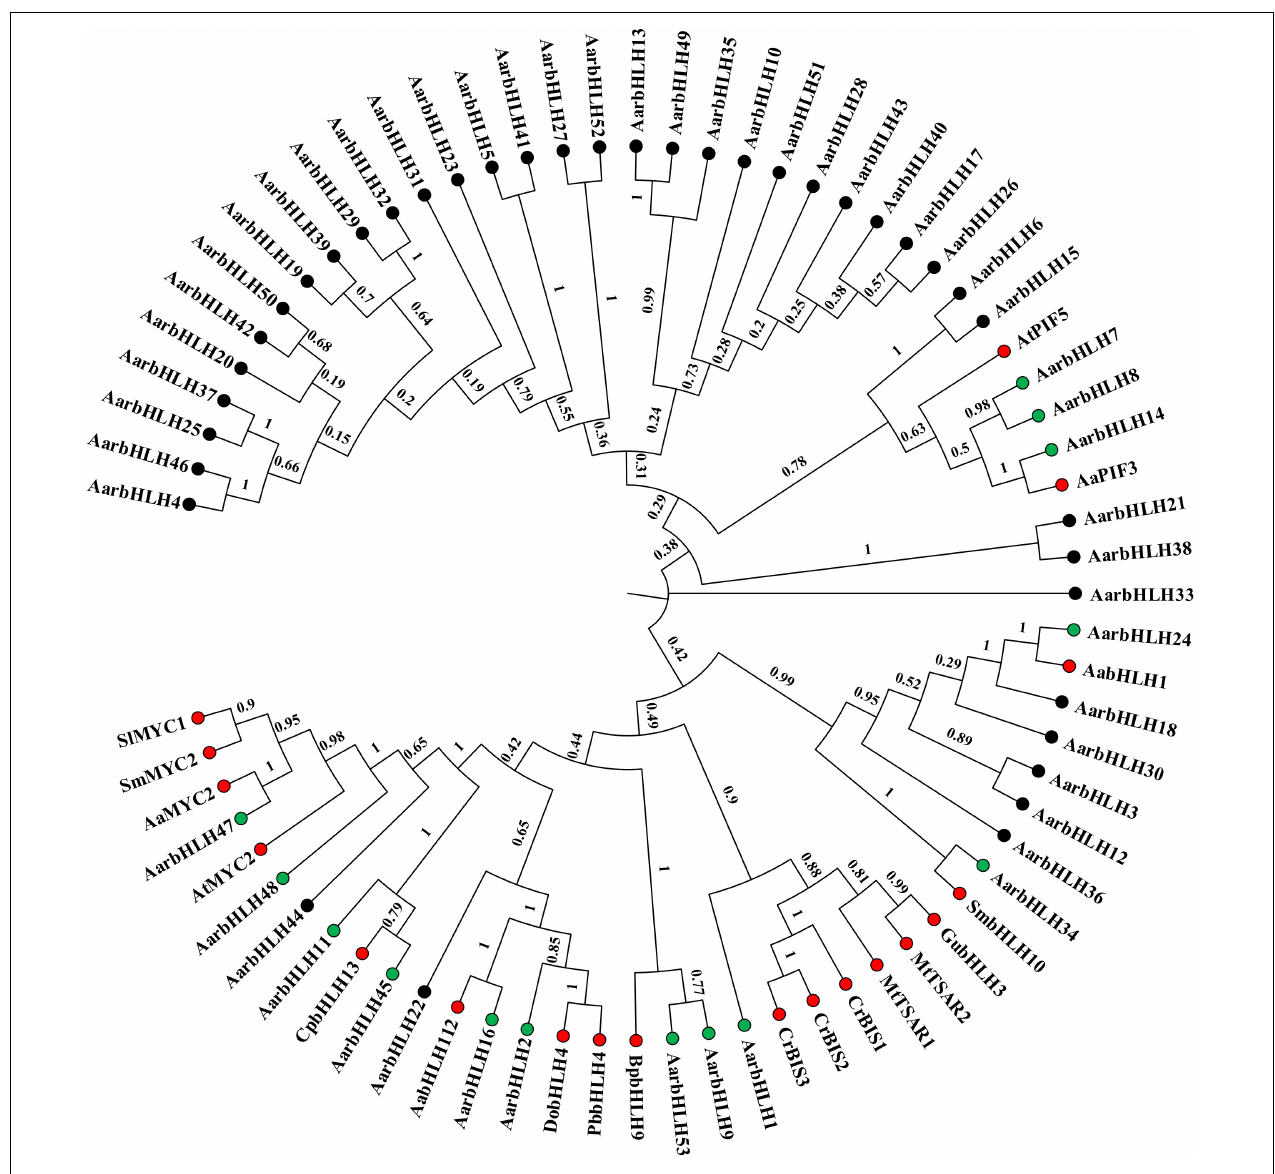
FIGURE 7 | The phylogenetic tree analysis based on the protein sequences of 53 AarbHLHs and nine known TPS-bHLHs by Neighbor-Joining (NJ) tree method. Red dots represent TPS-bHLHs. Green dots represent TPS-AarbHLHs. The number on the branch represents the confidence of the